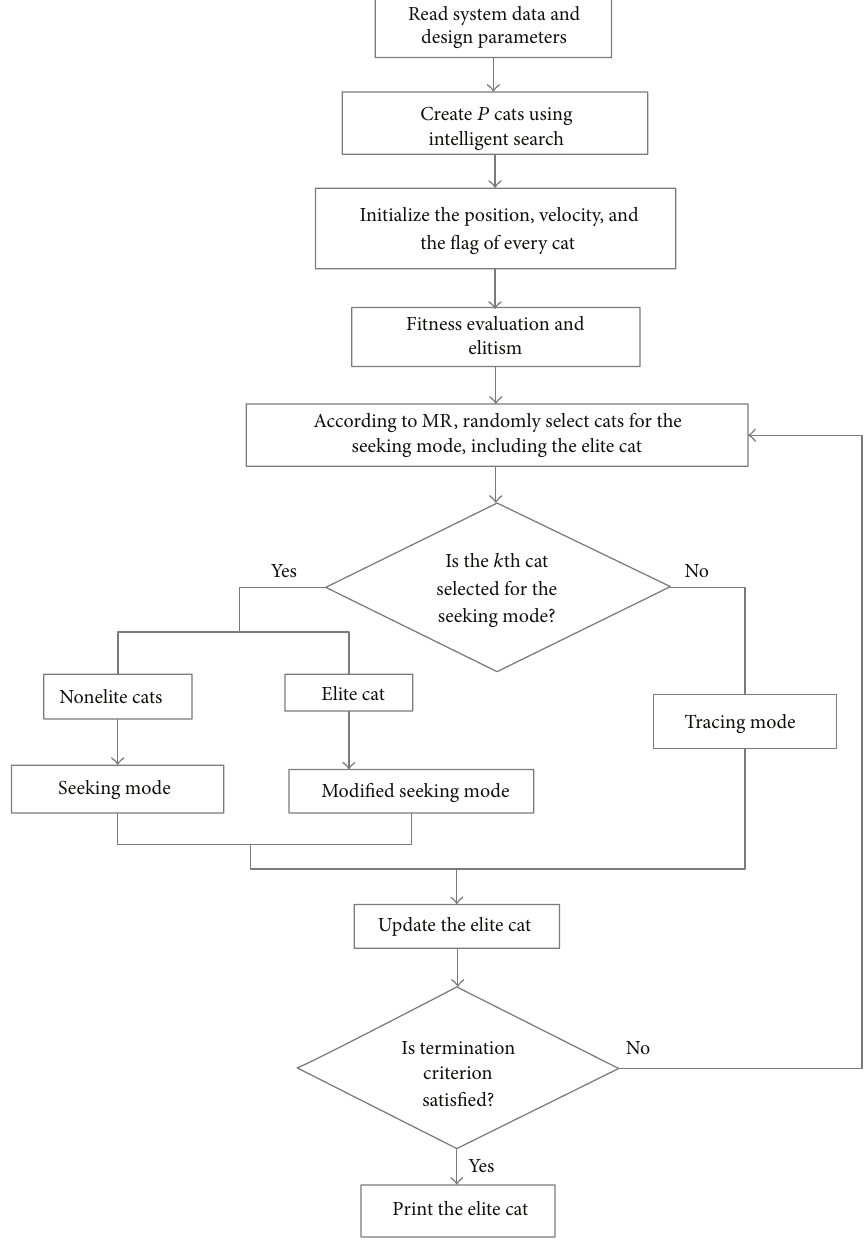
Figure 5: Flowchart of the proposed ICSO.